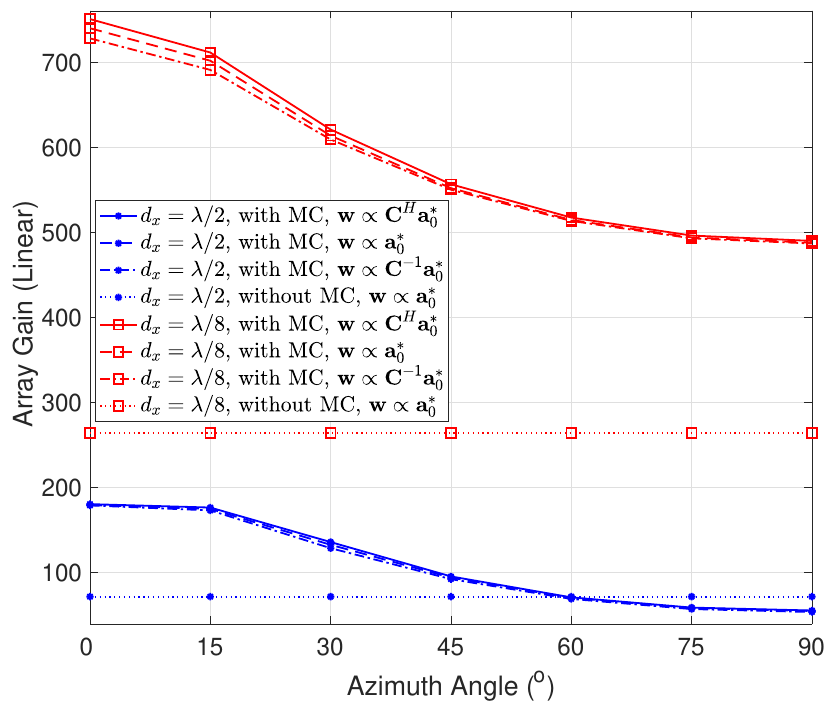
Figure 7. Transmit (Tx) array gain as a function of the azimuth angle for both without and with mutual coupling (MC) cases. The RIS size is 4 λ × 4 λ , the vertical element spacing is about λ /2, and the zenith angle is set to 90 ◦ . d x , w , C , and a 0 denote the element spacing along the x -axis, beamforming vector, coupling matrix in (30), and MC-unaware array response vector in (5),